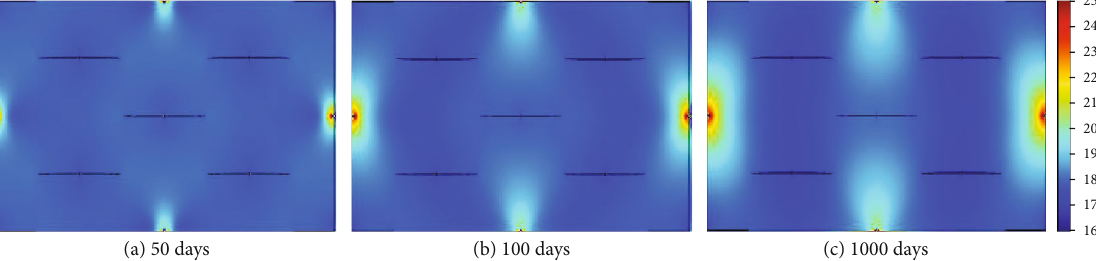
Figure 10: Minimum stress distribution in di ff erent developing periods.